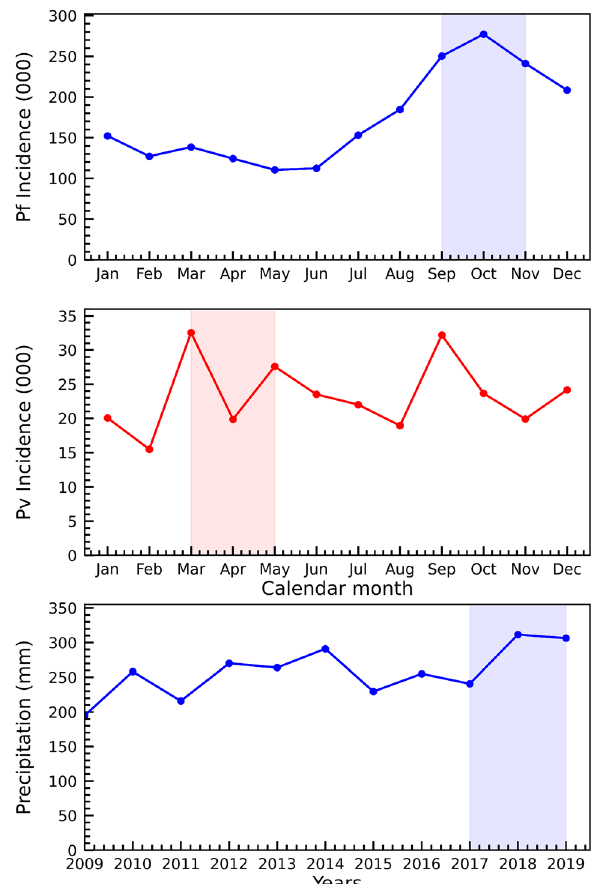
Figure 9. The seasonal variation of clinical species-specific malaria incidence in Sudan, Plasmodium falciparum (upper panel) and Plasmodium vivax (middle panel). The shaded regions represent the main peak of transmission of each species. The lower panel shows annual mean rainfall in Sudan between the year 2009 and 2019 and the shaded area highlights the modelled years. This figure was created in R (https:// www.r- proje ct. org/) using the ggplot